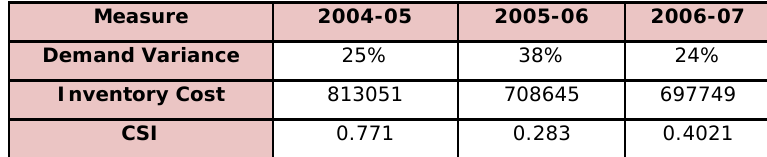
Table 13. “Effects of VMI